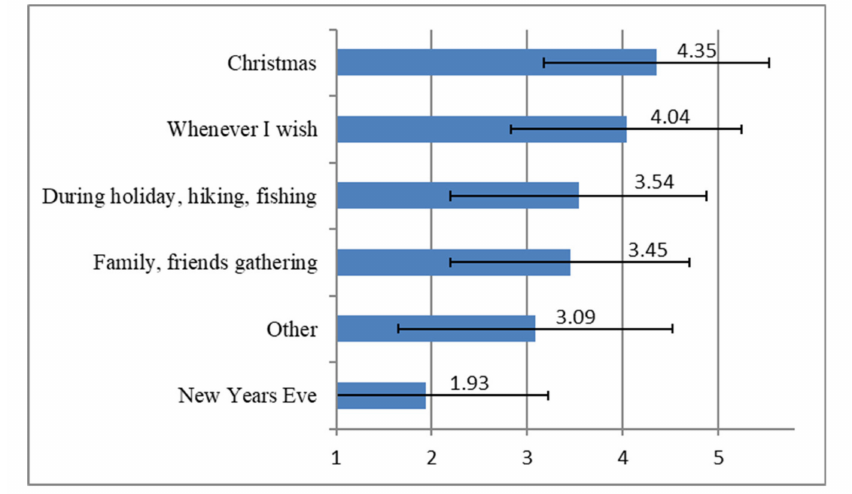
Figure 1. The occasions of carp